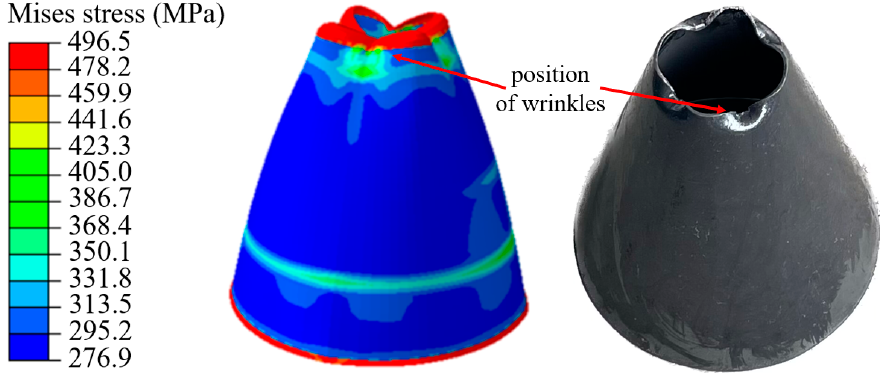
Figure 17. Wrinkle in XOZ plane during TUBG process with pressure of 9 MPa.